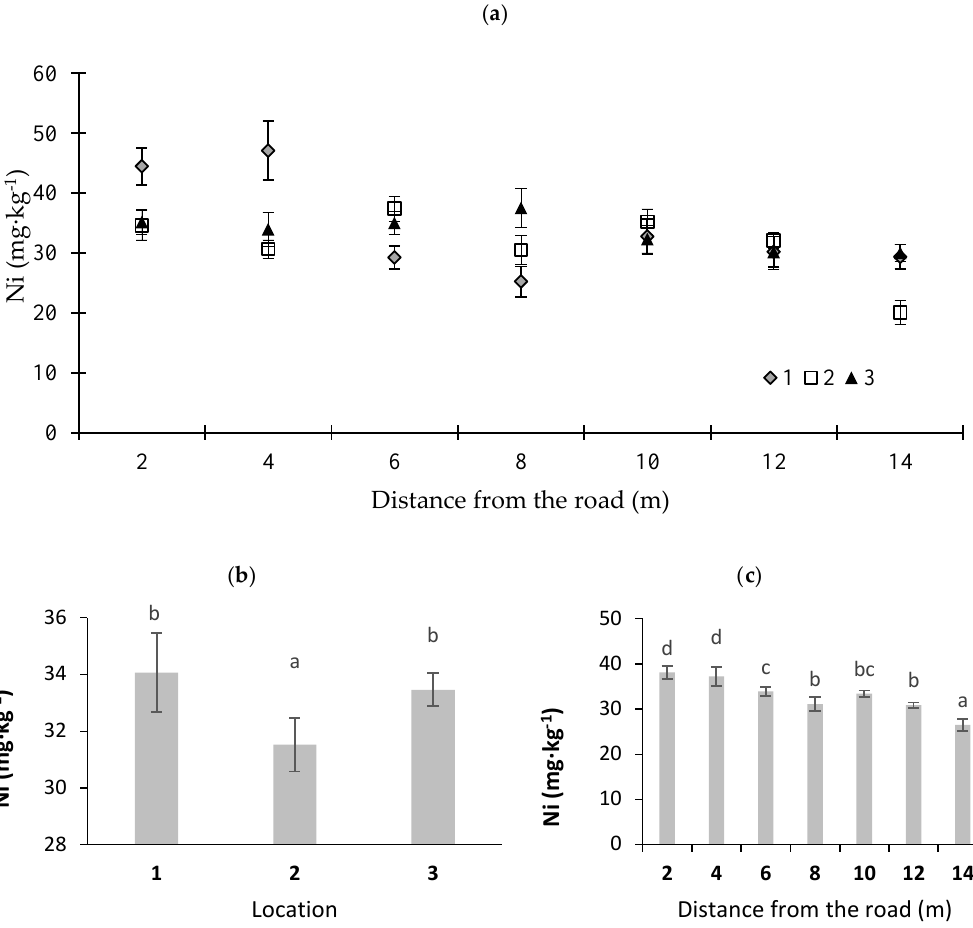
Figure 4. Nickel concentrations in moss ( P. schreberi ): ( a ) distance from the road at sampling location, ( b ) average Ni content at di ff erent locations, and ( c ) Ni content at di ff erent distances from the road (average values from three locations) ( n = 5, ± standard deviation). Di ff erent letters above bars representing lead concentrations for di ff erent locations or for di ff erent distances from the road indicate that they di ff ered significantly (Tukey’s test, p < 0.01).